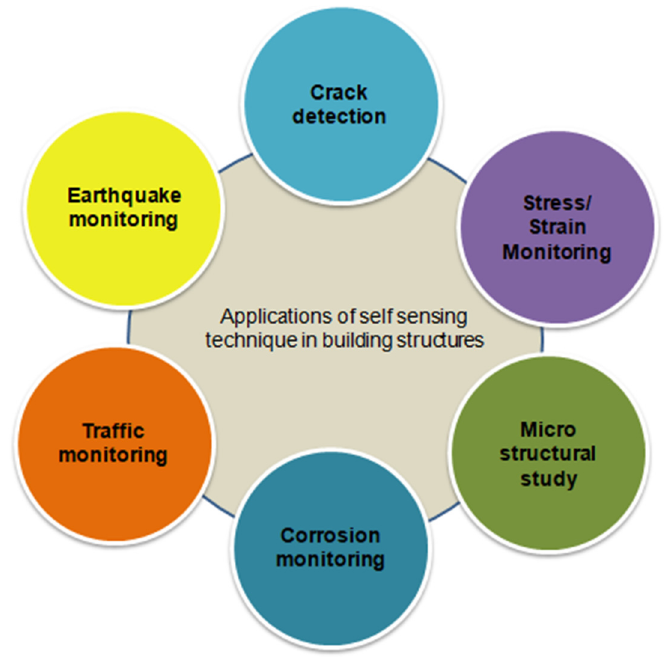
Figure 1. Applications of self-sensing in building elements.